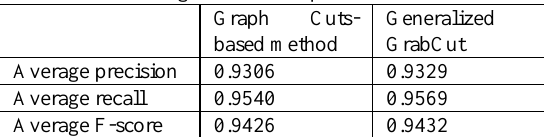
Table 3. Average precision, recall and F-score of the